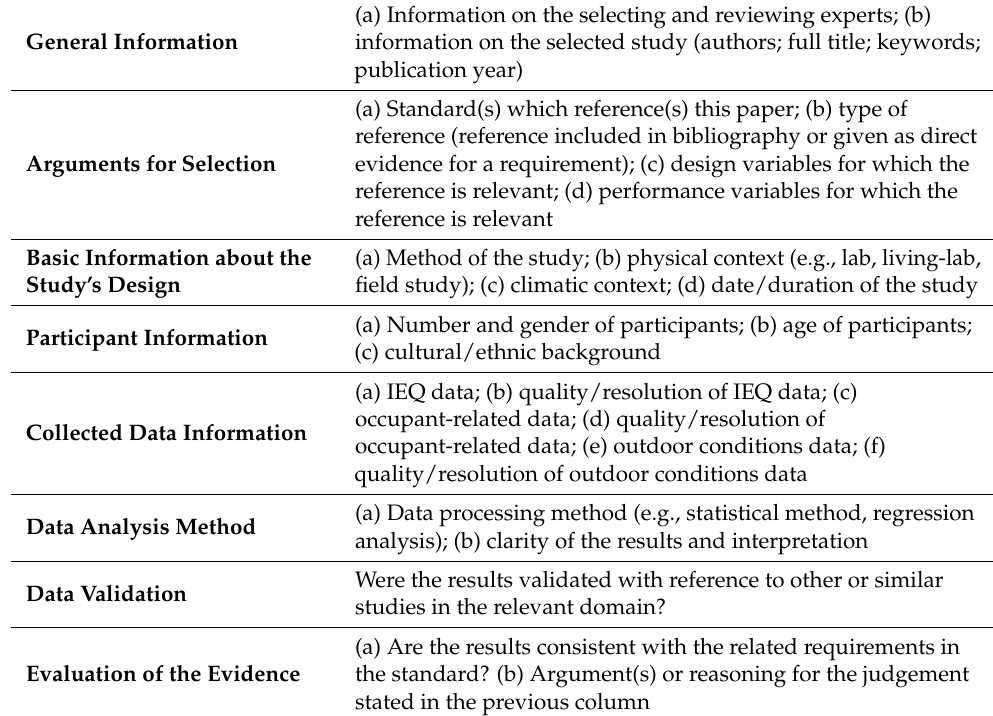
Table 2. Evidence assessment matrix